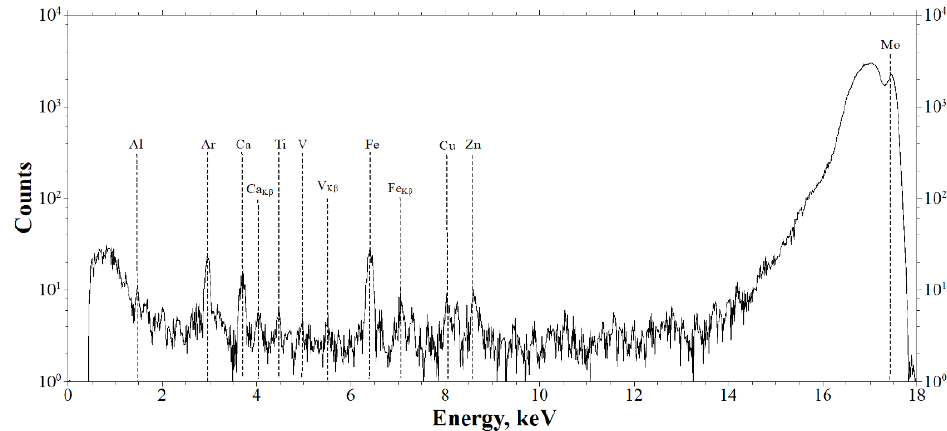
Figure 3. The XRF spectra of the elemental composition of the sample (the fibrous capsule adjacent to the Nobel Replace system implant).